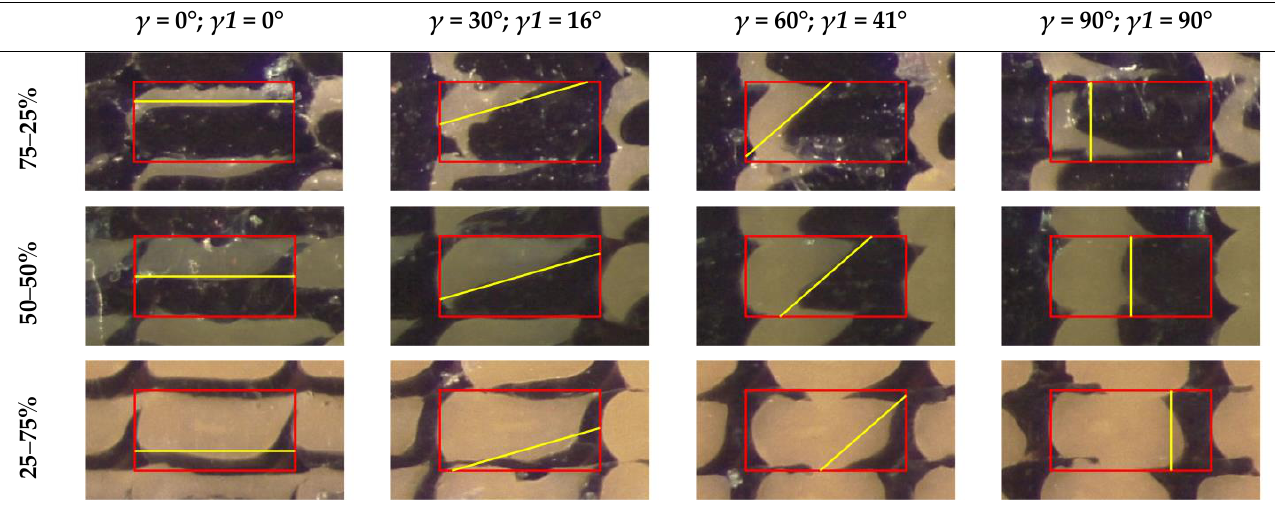
Figure 13. Actual cross section of the material deposited and rectangular model superimposition for the couple PLA-TPU for different material fractions. The rectangular model is highlighted in red, whereas the inclination of the interface is highlighted in yellow.